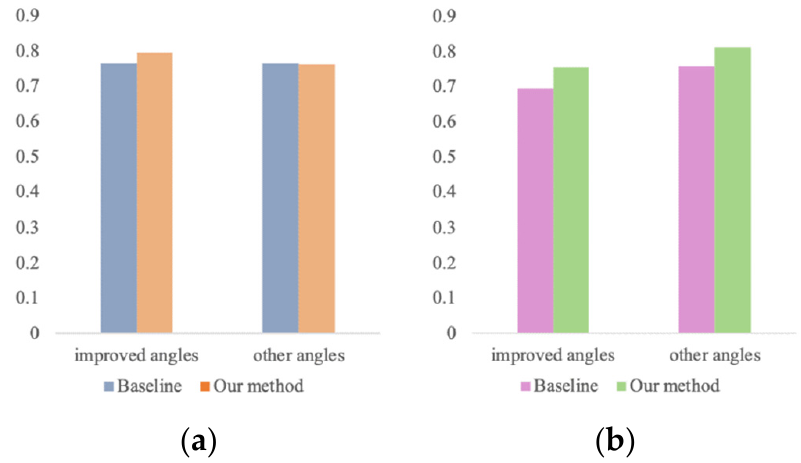
Figure 6. Recall rates of targets from different angles. The ordinate is different recall rates with the same accuracy. ( a ) DOTA. ( b ) HRSC. Our method can effectively improve the recall rate of the target when the target is different from the anchor. When the target angle is the same as that of the anchor, it is basically the same under the dataset, and it is still improved under the HRSC2016 dataset.